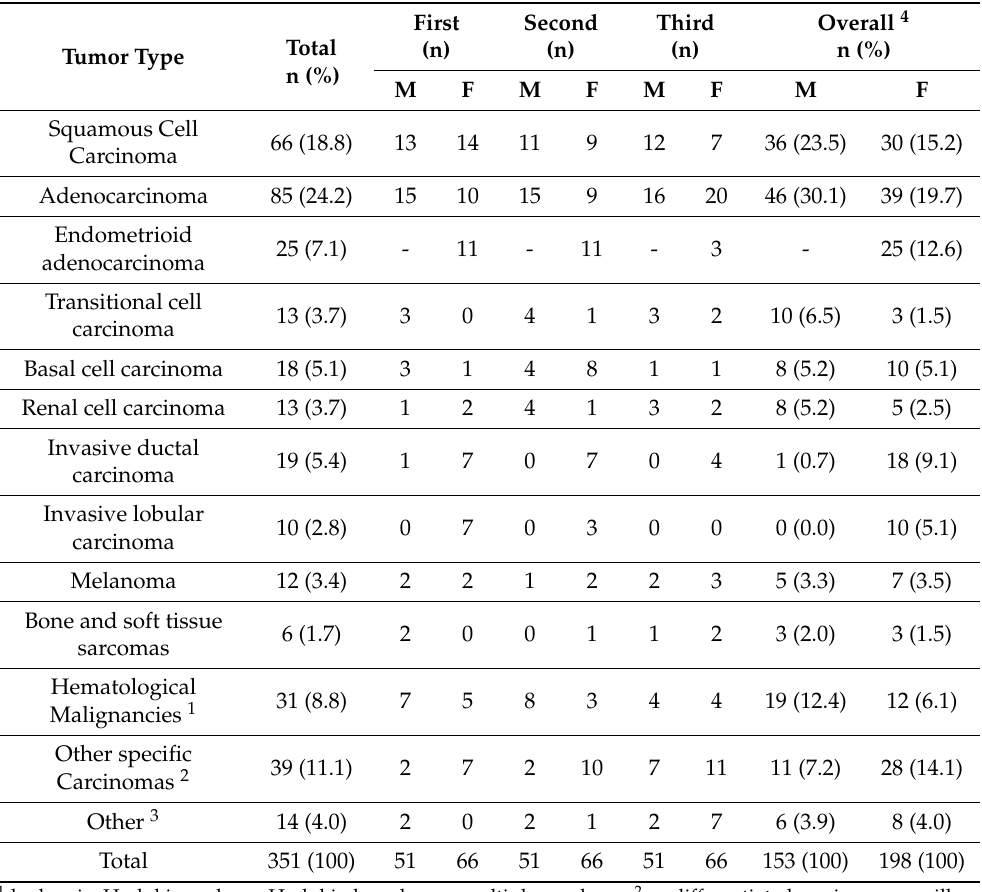
Table 3. Histological type distribution based on gender and the time of